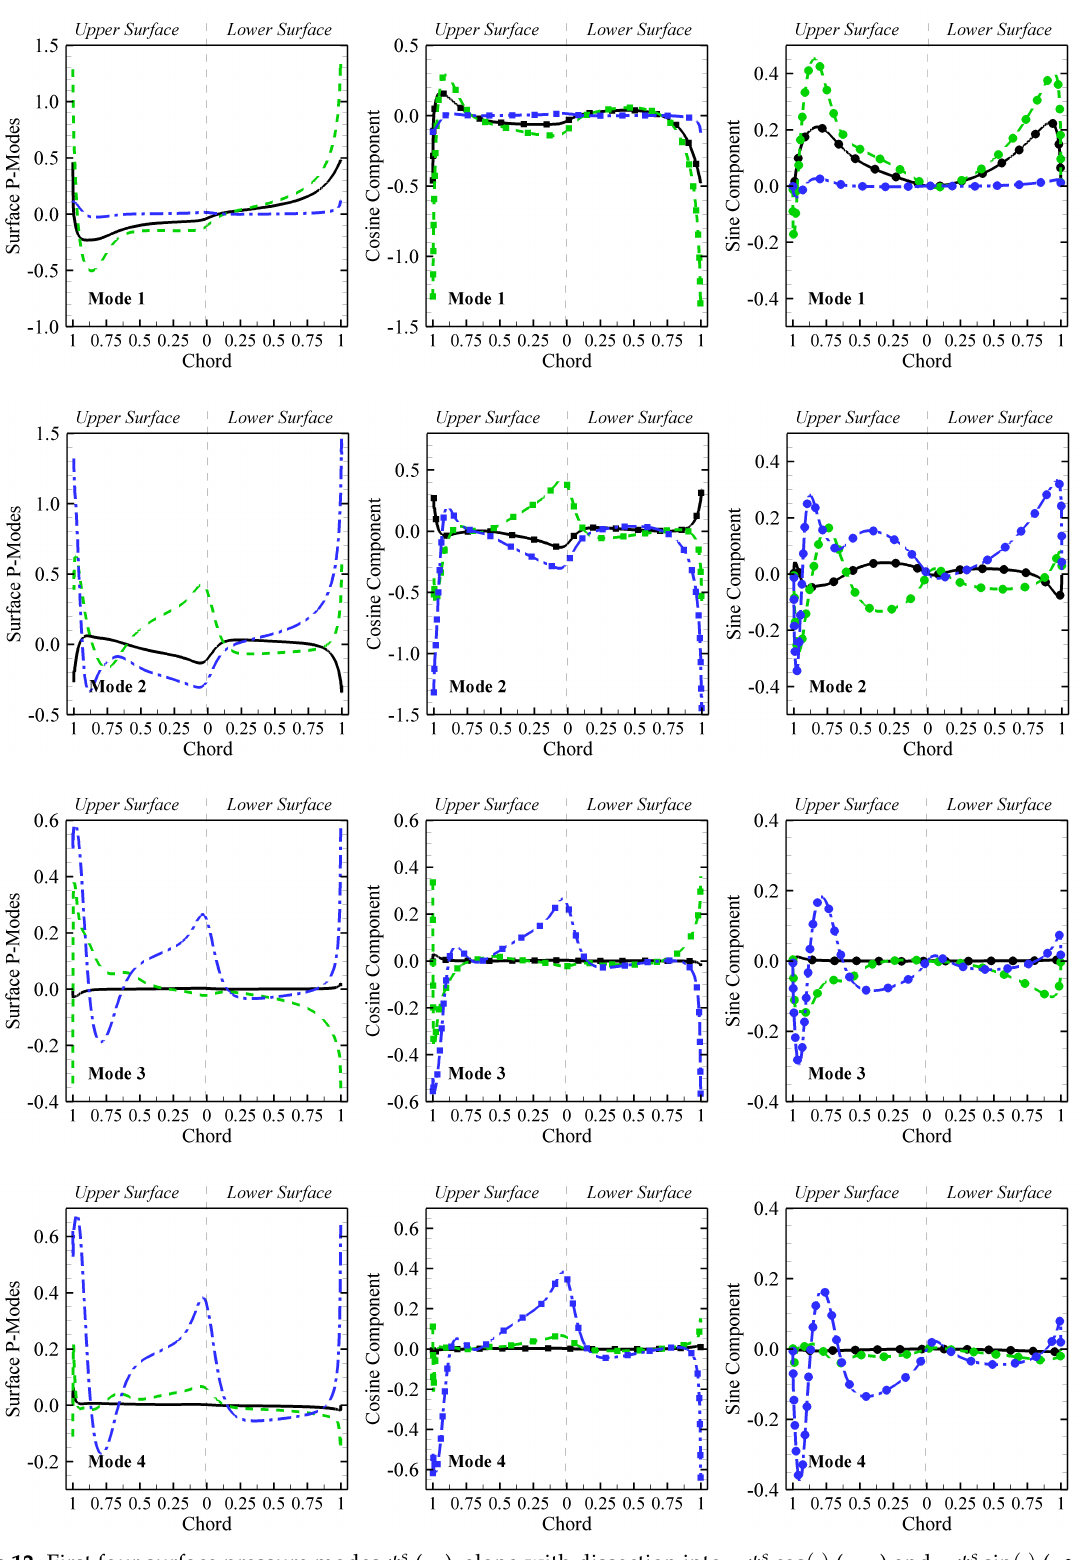
cos ( . ) ( ) and − ψ s sin ( . ) ( ): ( i i